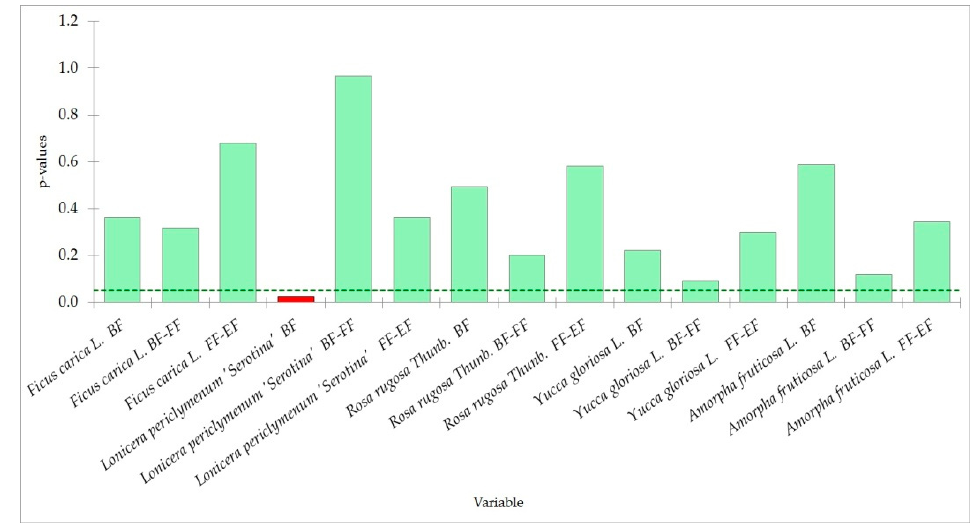
Figure 6. Graphical representation of Sen’s slope and p -value for the average number of days to the beginning of the flowering (BF), from the start to full flowering (BF-FF), and from the full flowering to the end of flowering (FF-EF) for 13 woody taxa in the period 2007–2022 for Belgrade (top) and Sur č in (bottom).